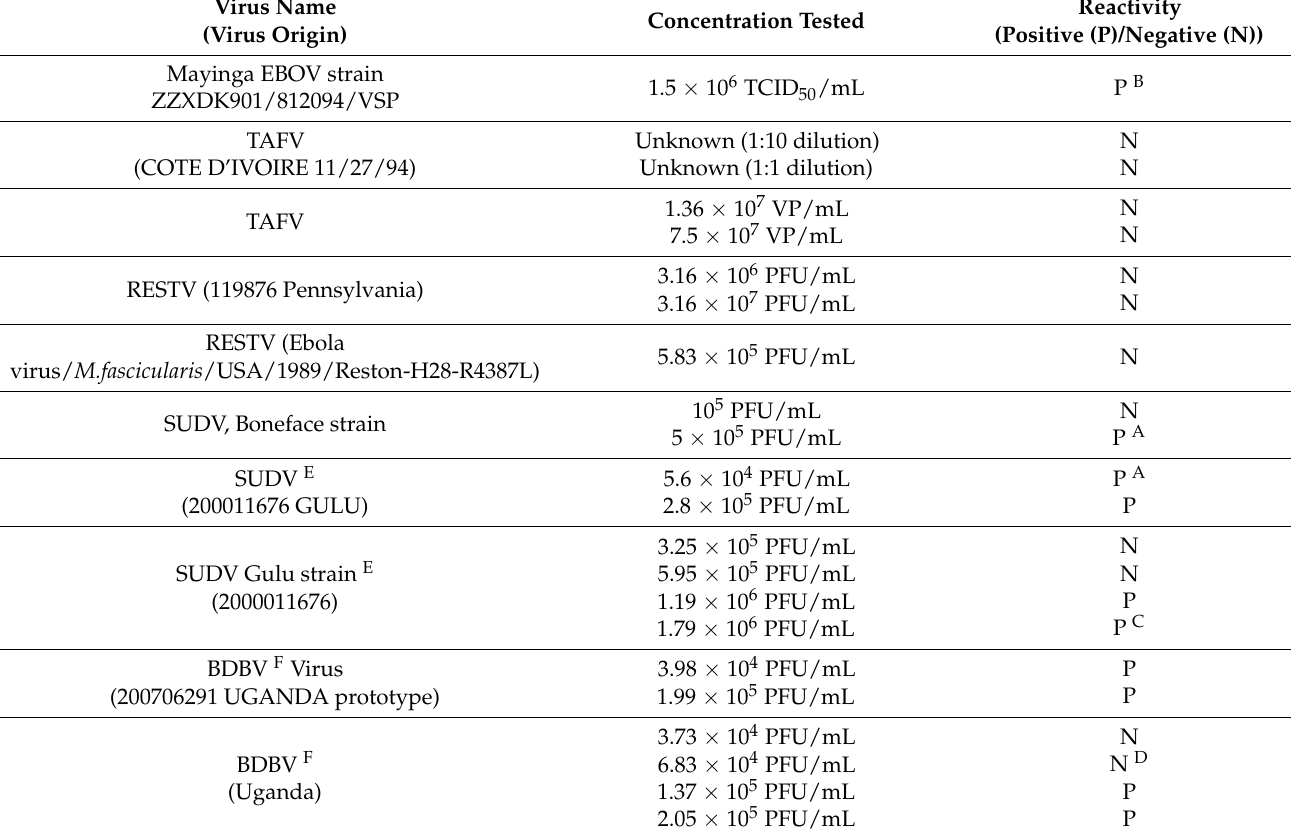
Table 5. Detection of inactive viruses from the genus Ebolavirus with Ebola Rapid Antigen Test in whole